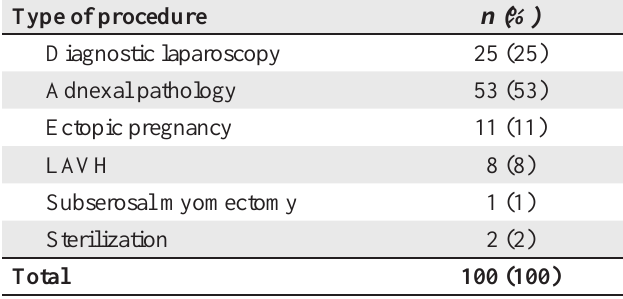
Table 1 : Type of surgeries performed.